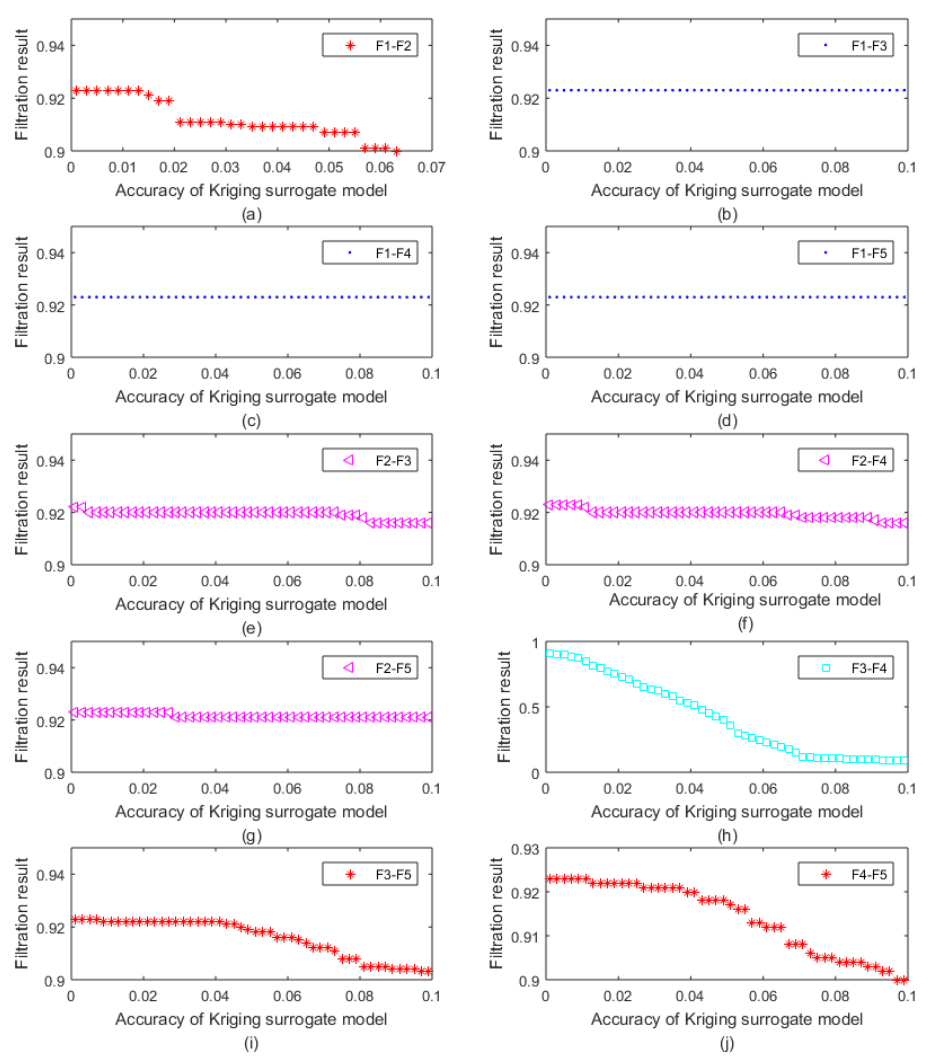
Figure 10. Filtration percentage results of interference reduction by the Kriging surrogate model for the settlement surveillance sensor (F1, F2, F3, F4 and F5 are the first five order natural frequencies, respectively). ( a ): F1-F2; ( b ): F1-F3; ( c ): F1-F4; ( d ): F1-F5; ( e ): F2-F3; ( f ): F2-F4; ( g ): F2-F5; ( h ): F3-F4; ( i ): F3-F5; (j): F4-F5.